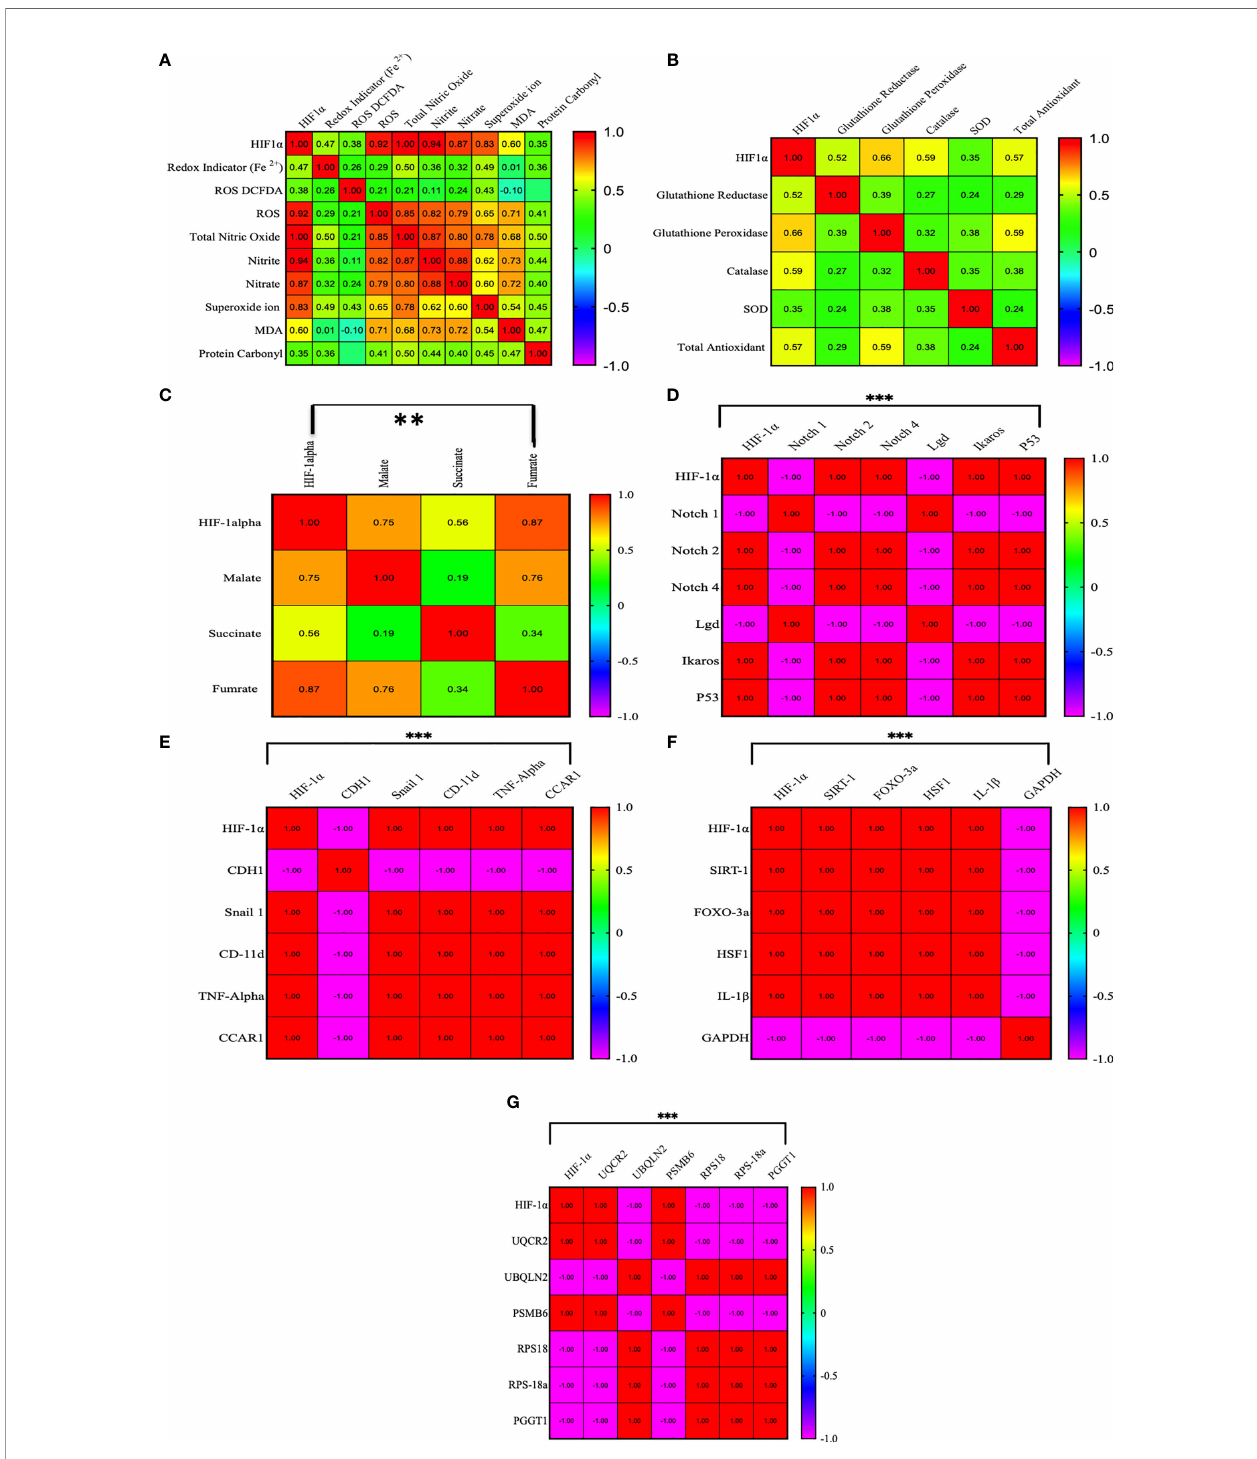
FIGURE 7 | Pearson correlation between HIF1 a and all the factors. (A – G) HIF1 a has a strong positive correlation with ROS (0.922, p = 0.01), total NO (0.99, p = 0.01), nitrite (0.94, p = 0.01), nitrate (0.873, p = 0.01), and superoxide ions (0.827, p = 0.01), while HIF1 a does not show a strong correlation with other redox factors. However, HIF1 a had a positive correlation with malate (0.751, p = 0.01) and fumarate (0.871, p = 0.01) and a moderate positive correlation with succinate (0.562, p = 0.01). HIF1 a also showed a strong positive correlation with Notch 2, Notch 4, Ikaros, p53, Snail 1, CD-11d, TNF a , CCAR1, SIRT1, Foxo-3a, HSF1, IL-1 b , UQCR2, and PSMB6 (1.00, p = 0.001) and a strong negative correlation with Notch1, Lgd, CDH1, GAPDH, UBQLN2, RPS18/18a, and PGGT1B (-1.00, p = 0.001). **p >0.001; ***p